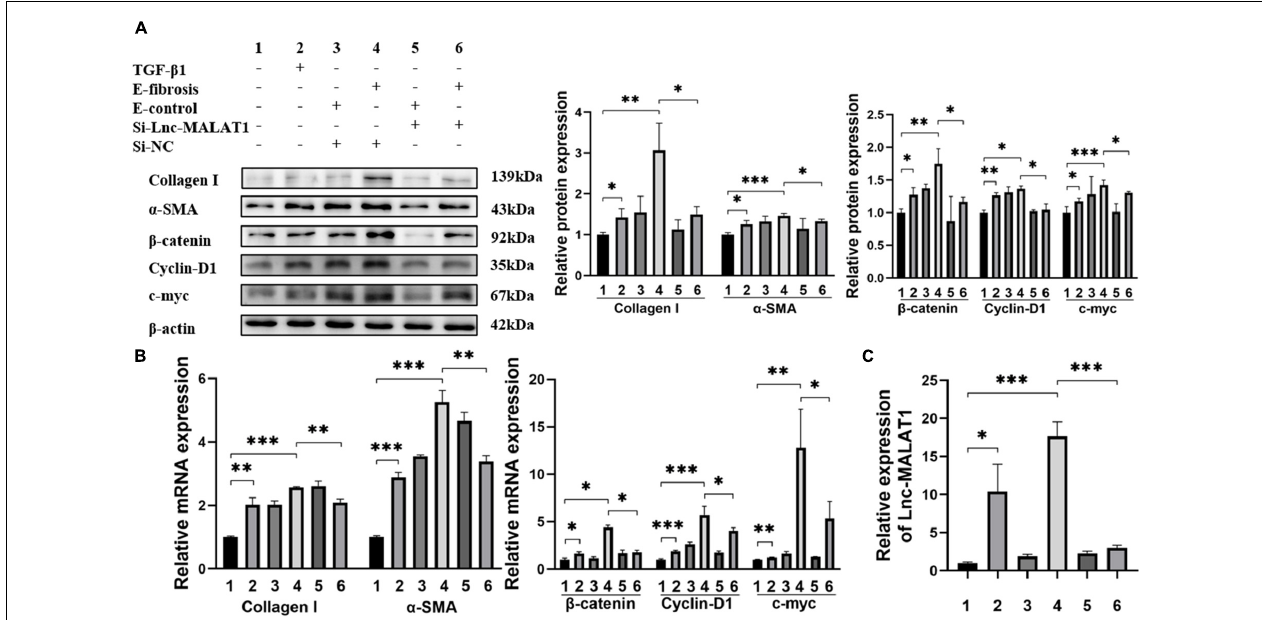
FIGURE 3 | Enhanced LX-2 activation and β -catenin signaling by EVs with highly expressed Lnc-MALAT1. LX-2 cells were transfected with Lnc-MALAT1-specific siRNA or irrelevant small RNA and then treated with plasma EVs from high liver fibrosis patients or from the control subjects and continued to culture for another 44 h. The cells were collected qRT-PCR and western blot analyses. Treatment with TGF- β 1 (10 ng/ml in PBS) was used as the positive control. (A) Western blot analysis of collagen I, α -SMA, β -Catenin, Cyclin-D1, and c-myc. The numbers indicate different treatment. Relative intensity of the bands was expressed in the middle and right panels ( n = 6). (B) qRT-PCR analysis of the mRNA expression of collagen I, α -SMA, β -Catenin, Cyclin-D1 and c-myc ( n = 6). (C) qRT-PCR analysis of the expression of Lnc-MALAT1 ( n = 6). ∗ , ∗∗ , and ∗∗∗ represent p- values less than 0.05, 0.01 and 0.001,